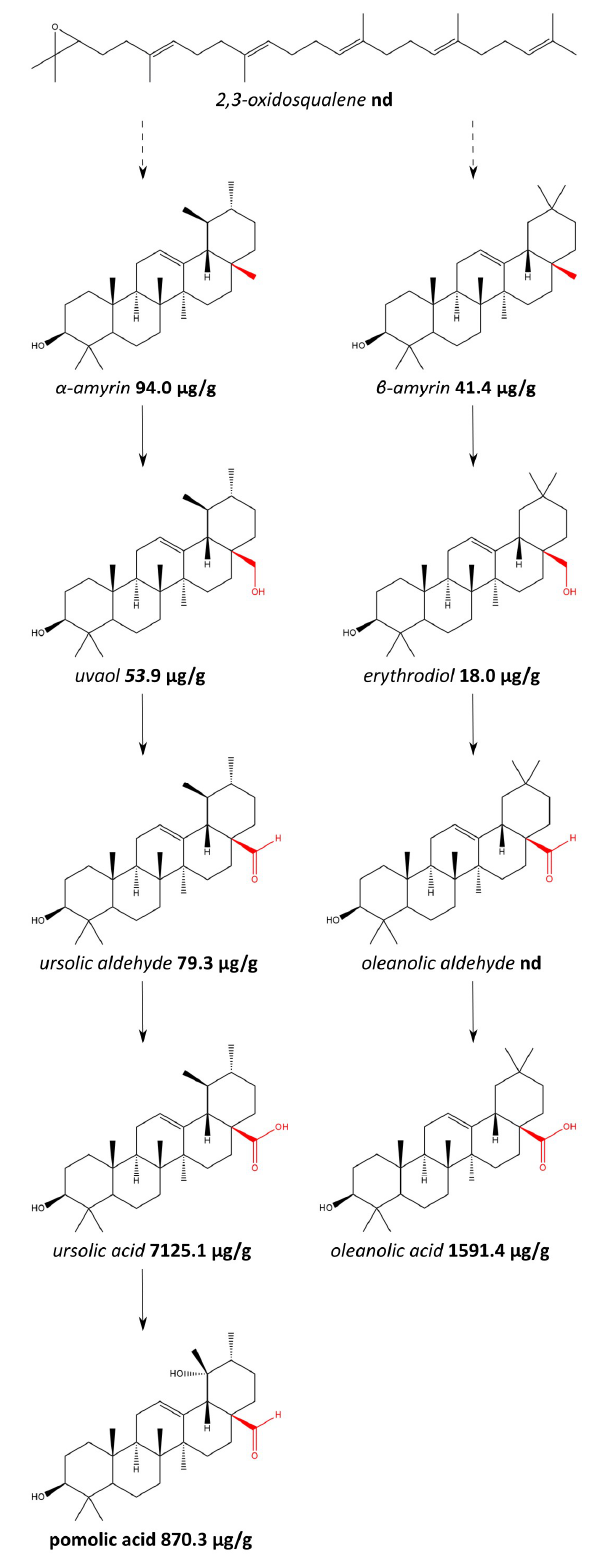
Figure 2. Triterpenic acids and intermediates of their biosynthesis; the results of quantification in the apple pomace. Abbr.: nd—not detected.